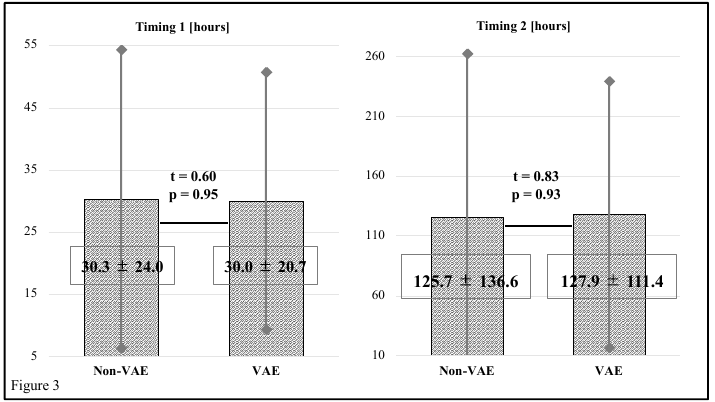
Figure 3 . Timing 1 values in the non-VAE group and VAE group were 30.3 ± 24.0 and 30.0 ± 20.7 h, and those of Timing 2 were 125.7 ± 136.6 and 127.9 ± 111.4 h, respectively. The differences were not significant ( t = 0.60, p = 0.95 and t = 0.83, p = 0.93, respectively). VAE = ventilator-associated events.